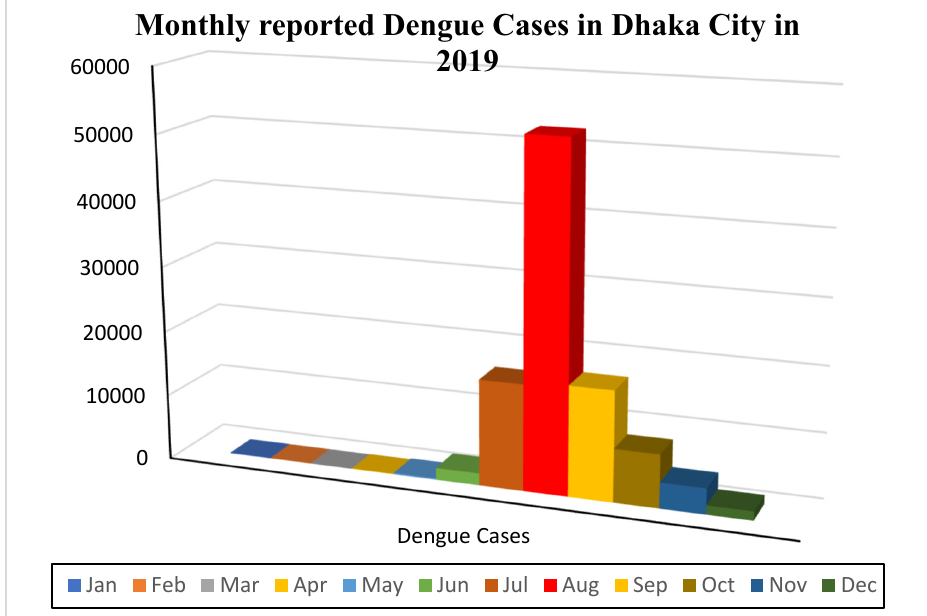
Figure 8. Total number of reported dengue cases in Dhaka City (2001–2019).